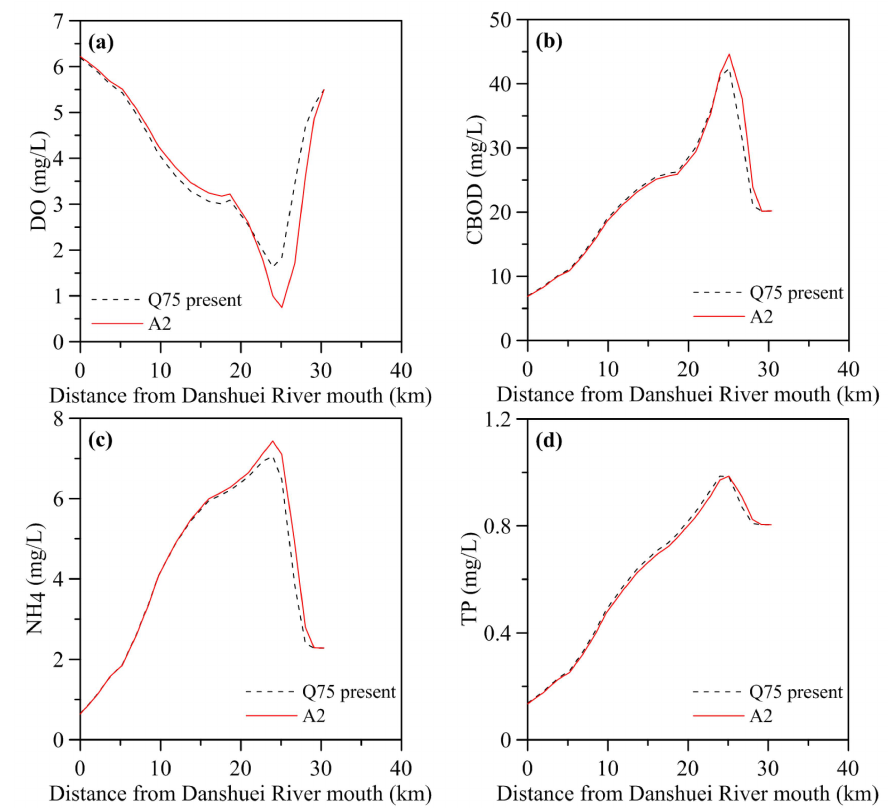
Figure 8. Predicting water quality distributions for present and climate change (A2 scenario) conditions under Q75 low flow along the Danshuei River to the Tahan Stream ( a ) DO; ( b ) CBOD; ( c ) NH4; and ( d )